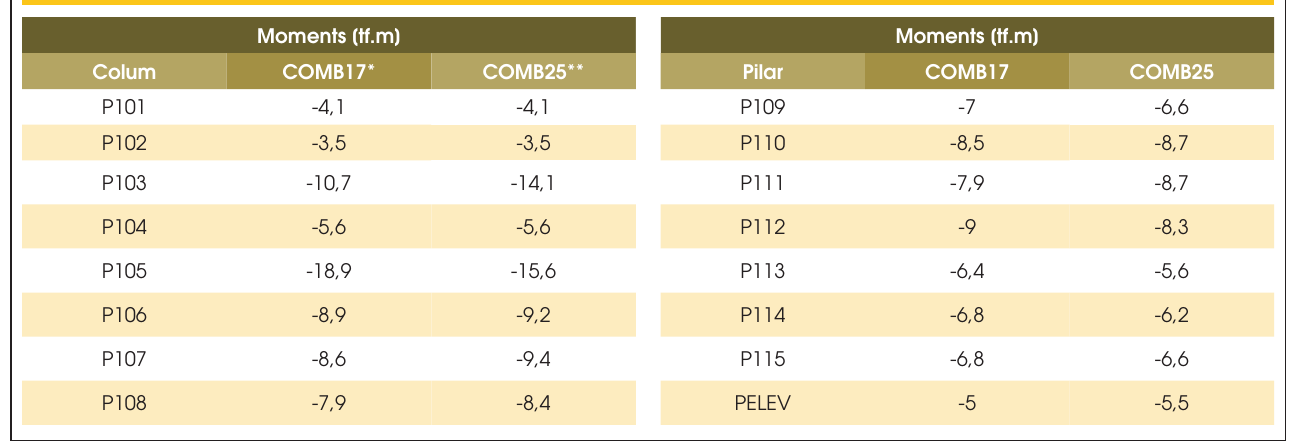
Table 6 – Moments in the region of the Coluns Model 3 - 1ª Analysis without Chapier Moments